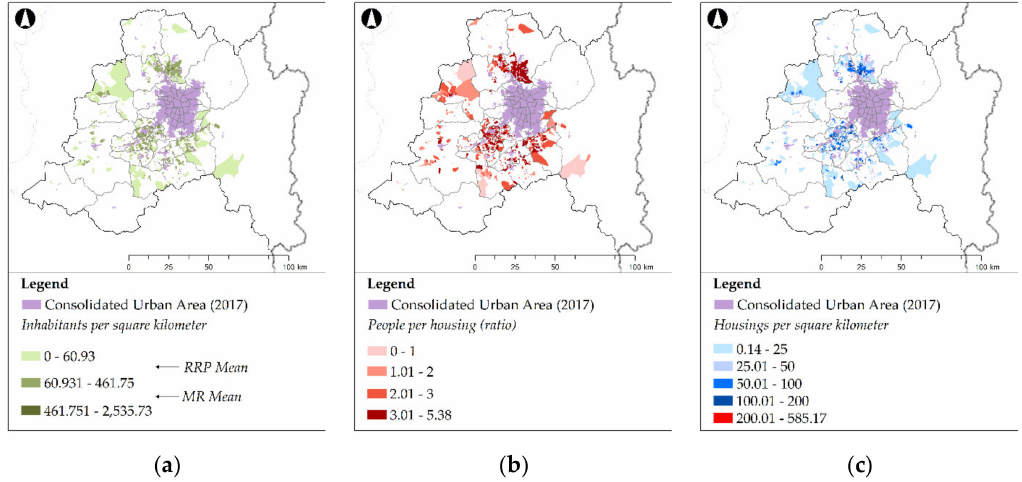
Figure 5. ( a ) Number of inhabitants per square kilometer, ( b ) people per housing unit, and ( c ) number of housing units per square kilometer. Source: Own elaboration, based on INE (2017) and MINVU